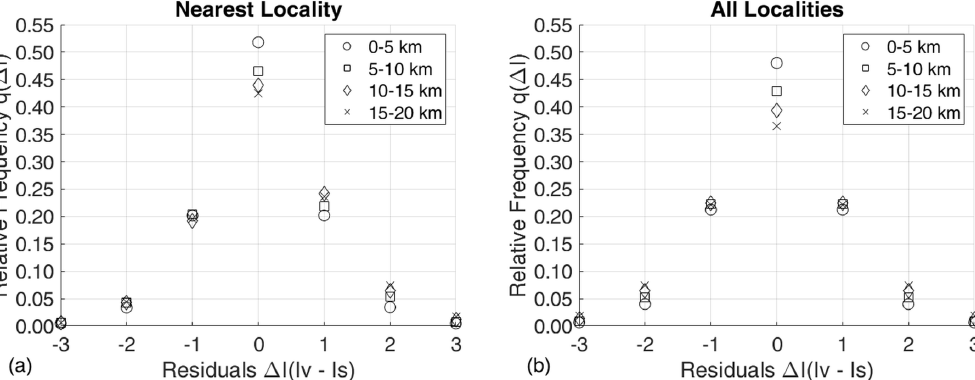
Figure 4. Relative frequency of q((cid:49)I) as a function of different distance ranges for (a) the nearest locality within 20km and (b) all the localities within 20km.